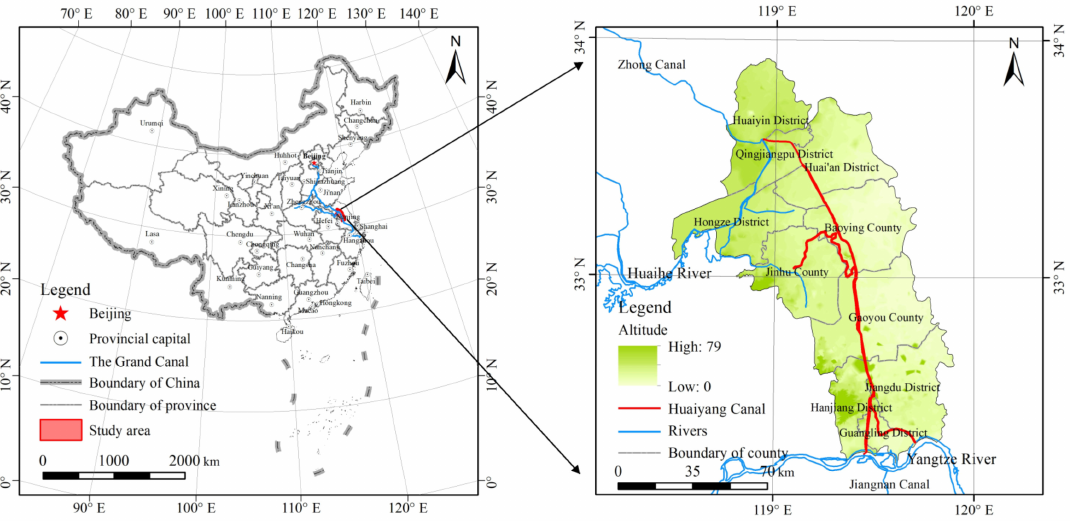
Figure 1. Location of the study